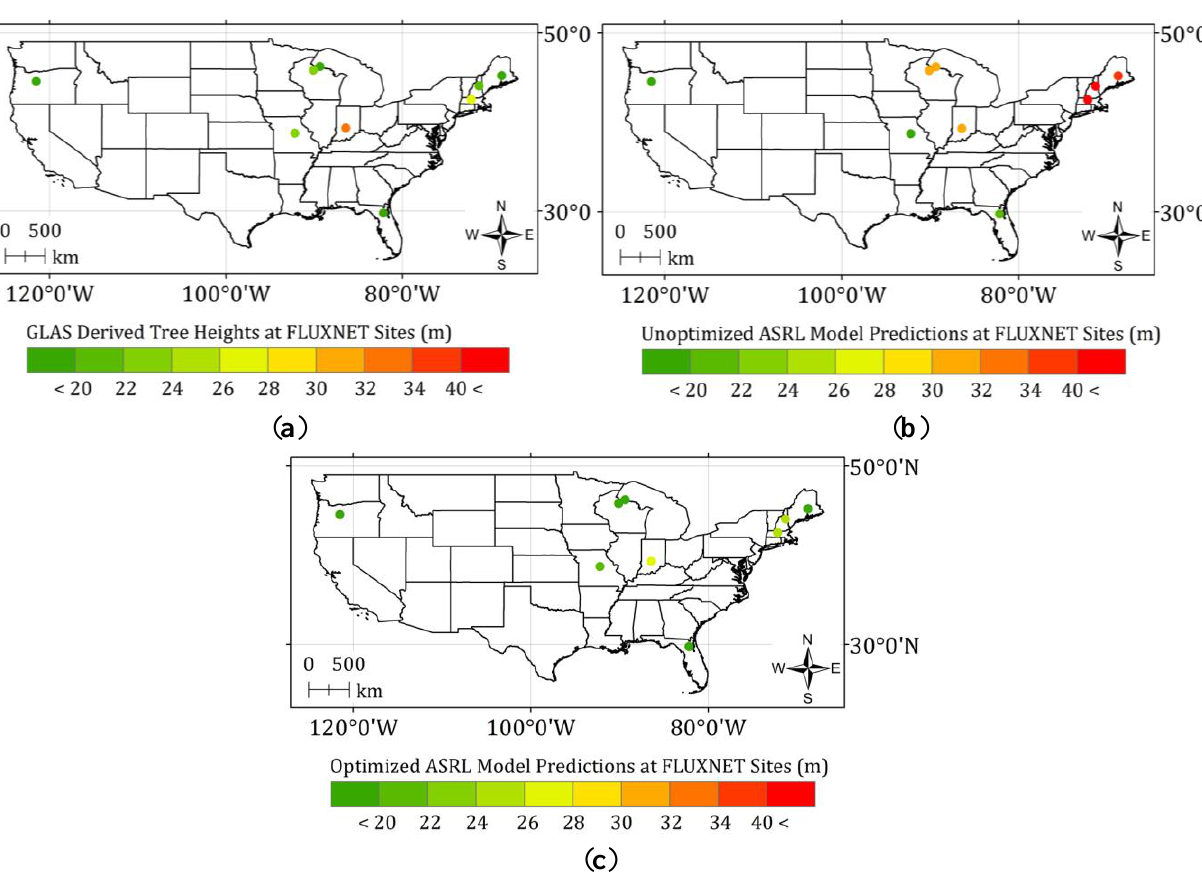
Figure 7. Distributions of tree heights over 12 FLUXNET sites: ( a ) GLAS tree heights, ( b ) unoptimized ASRL model predictions, and ( c ) optimized ASRL model predictions using training GLAS tree heights (two-fold cross